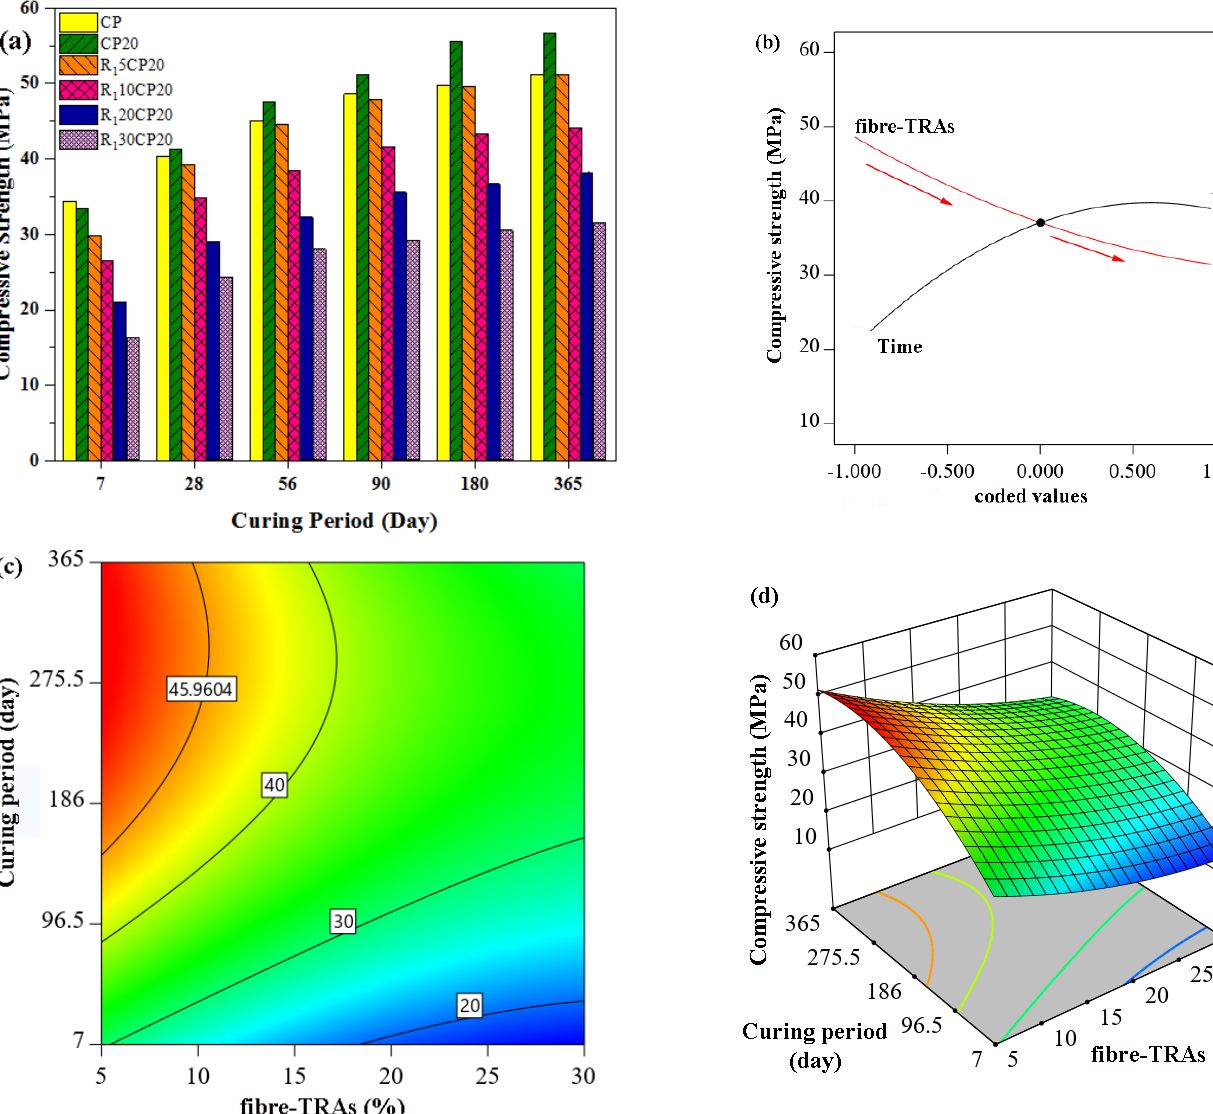
Figure 7. Effect of POFA concrete containing fibre-TRAs on compressive strength, ( a ) Experimental work, ( b – d ) RSM model. work, ( b – d ) RSM